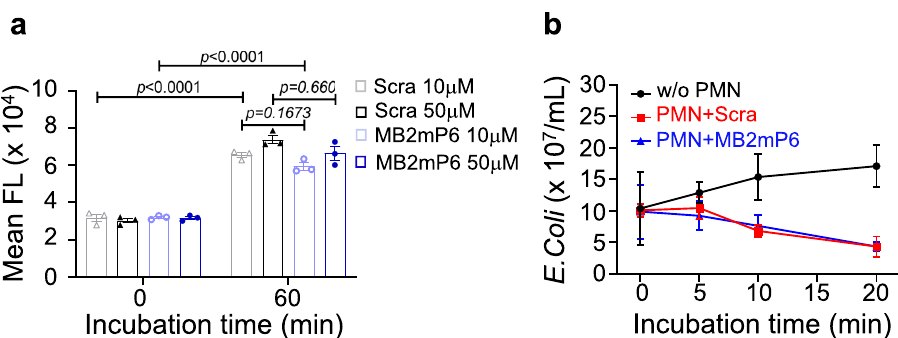
Fig. 2 MB2mP6 does not affect phagocytosis and bacteria killing by mouse neutrophils. a Phagocytosis of Alexa fl uor 488-labeled E. Coli by mouse neutrophils pretreated with MB2mP6 (10 or 50 μ M) as detected by fl ow cytometry (all groups, n = 3, independent isolated neutrophils). b In vitro E. coli (K-12 strain) killing by mouse neutrophils pretreated with MB2mP6 or scrambled control peptide (50 μ M) was detected at various time points (all groups, n = 4, independent isolated neutrophils). Data are shown as mean ± SEM. Data were analyzed by two-way ANOVA with the post hoc Tukey ’ s multiple comparisons